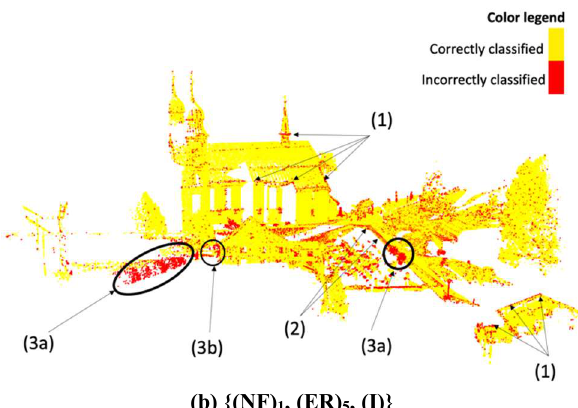
Figure 3. Classification by network with arrows showing the lo- cations of misclassification for (a) feature set C and (b) feature set